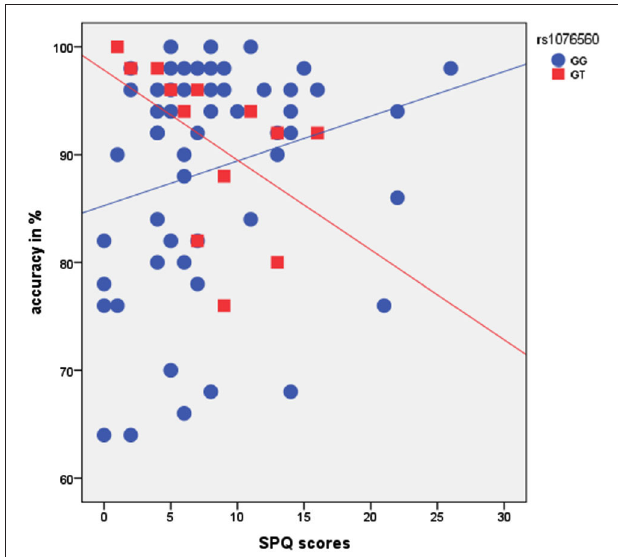
FIGURE 3 | Scatterplot showing the relationship between rs1076560, SPQ scores, and % accuracy in the VAC task . See text for statistics.